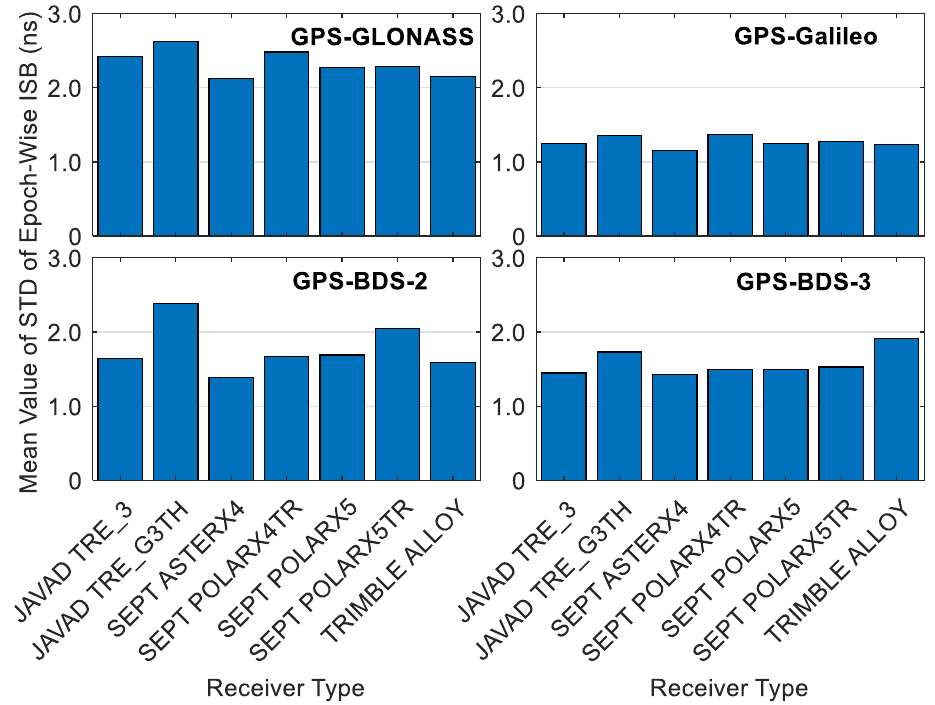
Figure 6. Average value of STDs of epochwise ISB estimates over a day for each receiver type based on the data sets from 120 stations spanning a month.